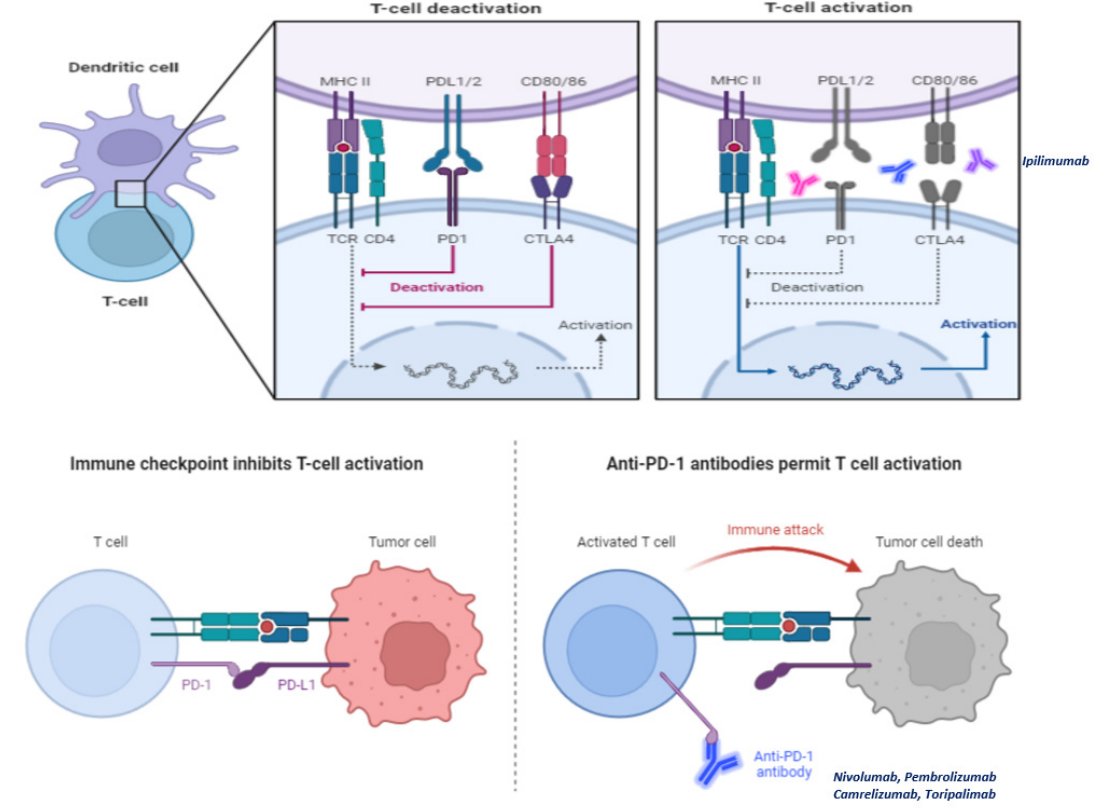
Figure 3. Check-point inhibitors act by removing the so-called “inhibitory brakes”, namely stimuli elicited through particular ligands (CTLA-4 and PD-1 for example) which lead cytotoxic T lympho- cytes (CTLs) to anergy. The molecules best known and used in clinical practice are CTLA-4 inhibitors (ipilimumab) and PD-1 inhibitors (nivolumab, pembrolizumab, camtelizumab, and toripalimab). Toripalimab is a humanized IgG4K monoclonal antibody targeting PD-1.